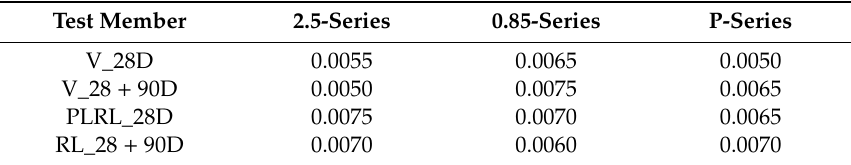
Table 9. Crack distribution density at bottom of specimens (/mm).